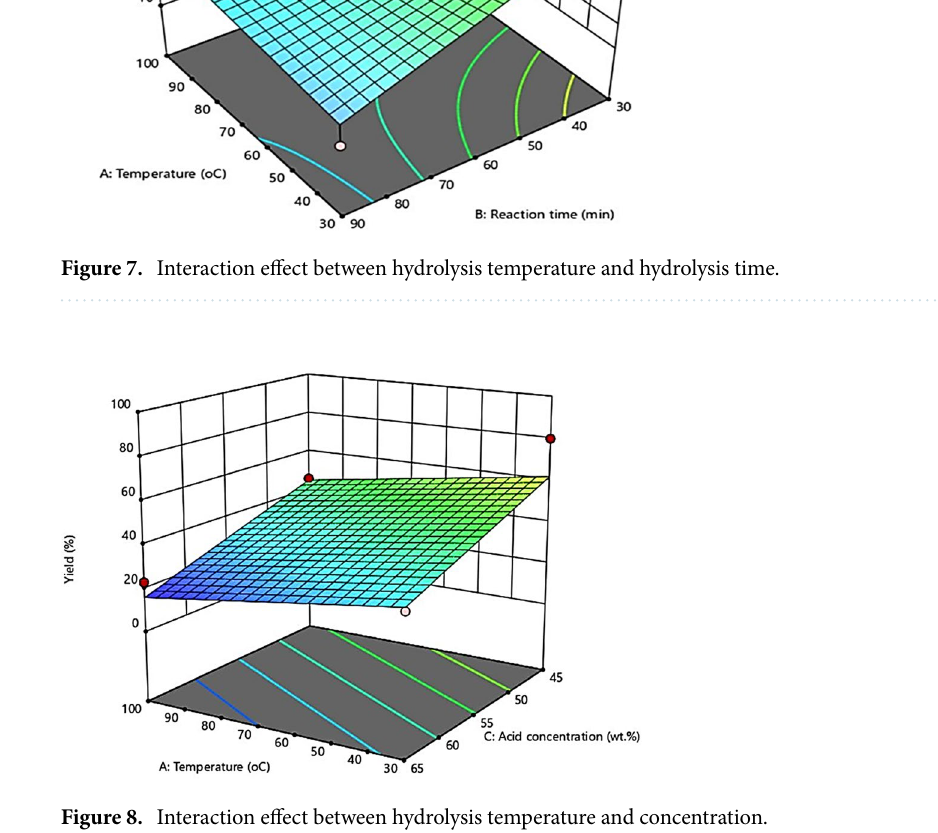
Figure 8. Interaction effect between hydrolysis temperature and concentration.